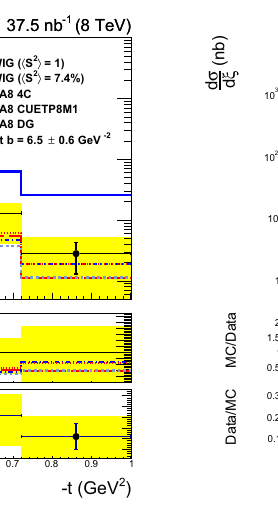
Fig. 4 Differential cross section as a function of t (left) and as a func- tion of ξ (right) for single-diffractive dijet production, compared to the predictions from pomwig , pythia8 4C, pythia8 CUETP8M1, and pythia8 DG. The pomwig prediction is shown with no correction for the rapidity gap survival probability ( (cid:6) S 2 (cid:7) = 1) and with a correction of (cid:6) S 2 (cid:7) = 7 . 4%. The vertical bars indicate the statistical uncertainties and